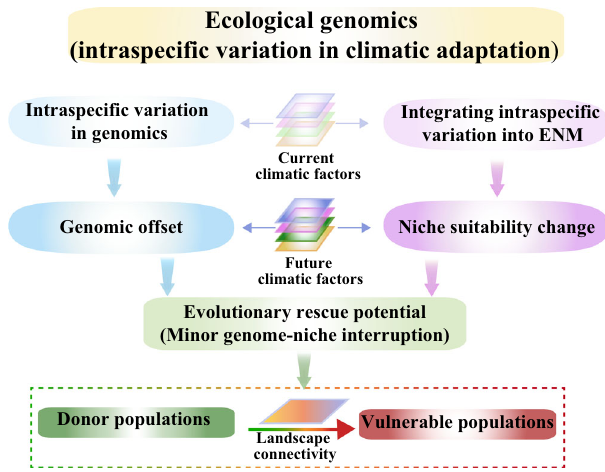
Fig. 1 | A framework integrating ecological genomics, niche modelling and landscape genetic analysis to evaluate climate change-driven vulnerability. A schematic representation of climate change-driven vulnerability modelling. We combine ecological genomics and niche modelling to evaluate the population- speci fi c responses of the two species to future climate change. We consider both the genomic offset and niche suitability change for potential evolutionary rescue. Only populations with minor genome-niche interruption can be regarded as a desired store of species ’ survival for climate change (i.e., being a donor). A land- scape genetic approach is then used to evaluate potential rescue